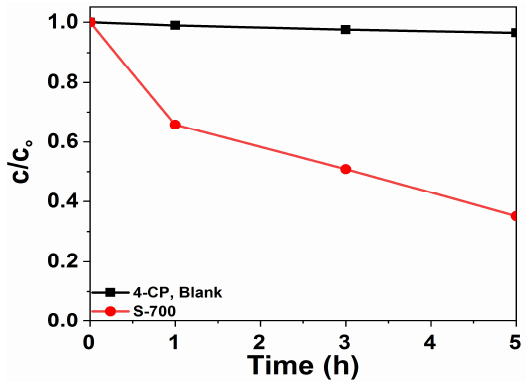
Figure 12. Degradation of 4-CP as a function of irradiation time without a photocatalyst and in the presence of the LaFeO 3 catalyst S-700.